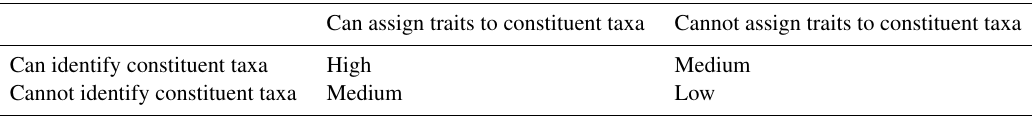
Table 3. Lifeform confidence assignment matrix, where “high”, “medium”, and “low” are based on the ability to identify and assign traits for the constituent taxa groups of a